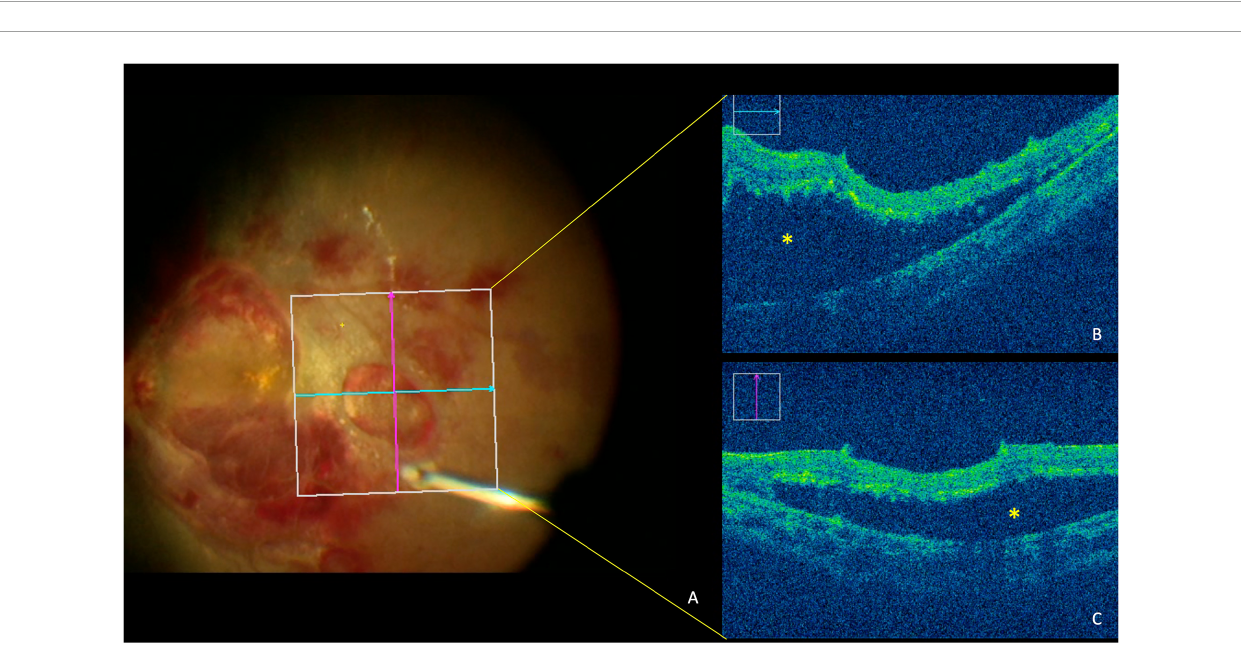
FIGURE2 Optical coherence tomography (OCT) image during surgery shows serous retinal detachment in posterior fundus of the right eye. (A) Fundus imaging from the retina’s view during surgery. (B) OCT imaging shows the horizontal B-scan of retina. (C) OCT imaging shows vertical B-scan of retina. Asterisks denote detachment of the neuroretina from the retinal pigment